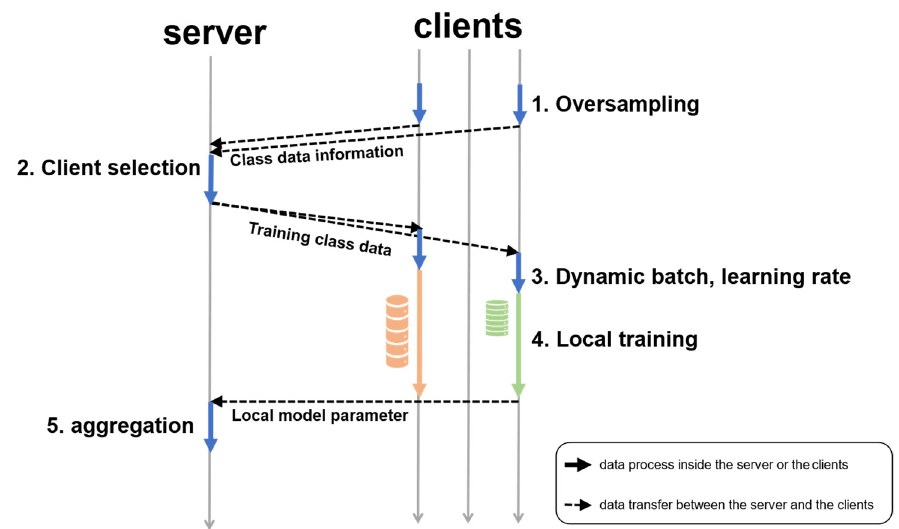
Figure 2. The workflow of the FL with the proposed algorithm, where the orange and green cylinders are the local datasets with different batch sizes. The solid arrow lines mean the data process inside the server or the clients, and the dotted lines mean the data transfer between the server and the clients.